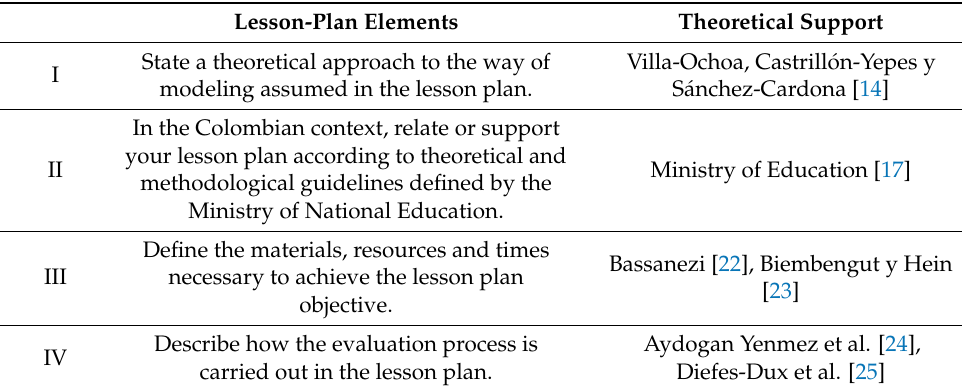
Table 3. Lesson-plans elements and